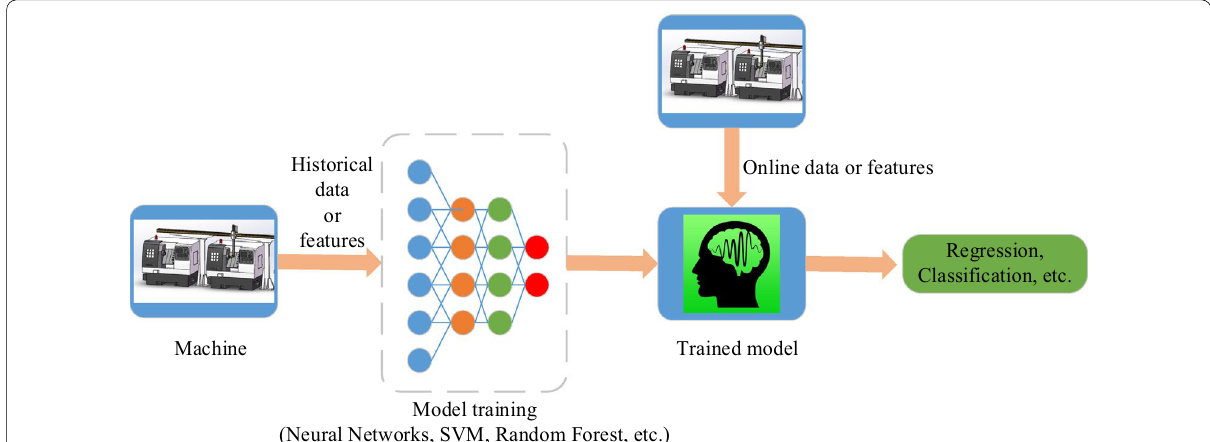
Figure 2 Basic framework of data-driven